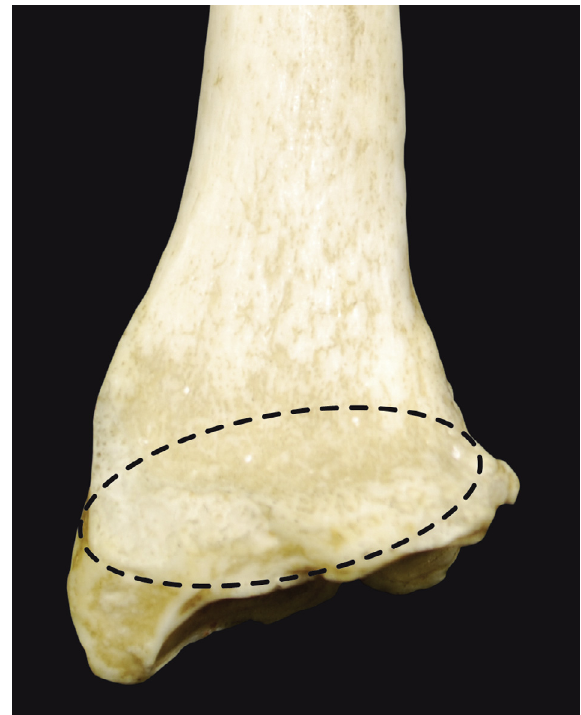
Figure 2. Volar view of the distal radius showing, in dotted line, the anatomical region of interest.